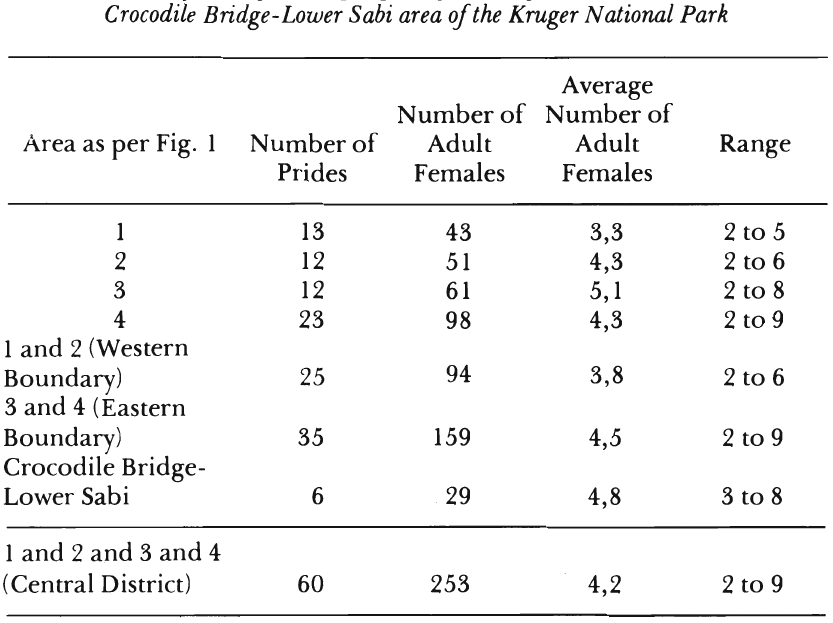
Average number of adult females per pride for lions from the Central District and Crocodile Bridge-Lower Sabi area rifthe Kruger National